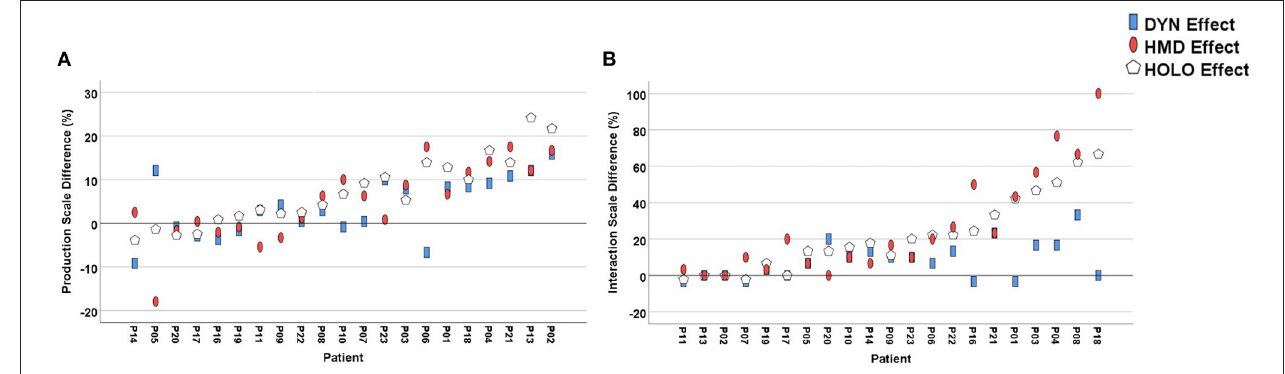
FIGURE 5 | Conditional (DYN), environmental (HMD) and combined (HOLO) effects of individual patients displayed in (A) Production Scale and (B) Interaction